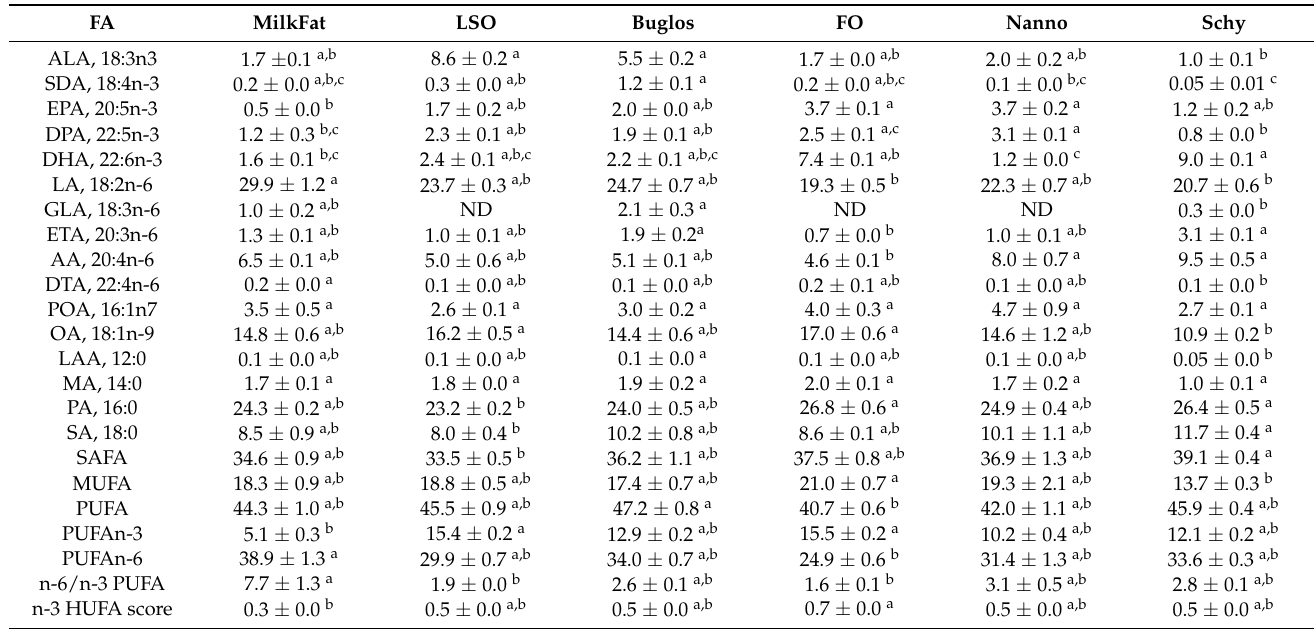
Table 3. Changes of fatty acid (FA) profile in liver of Wistar rats fed with different